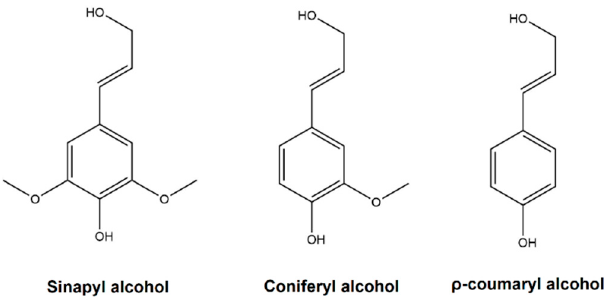
Figure 1. The three monolignols considered as the building blocks of lignin.